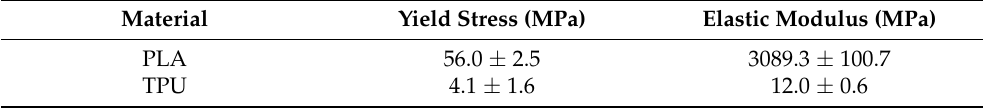
Table 2. Mechanical properties of the materials